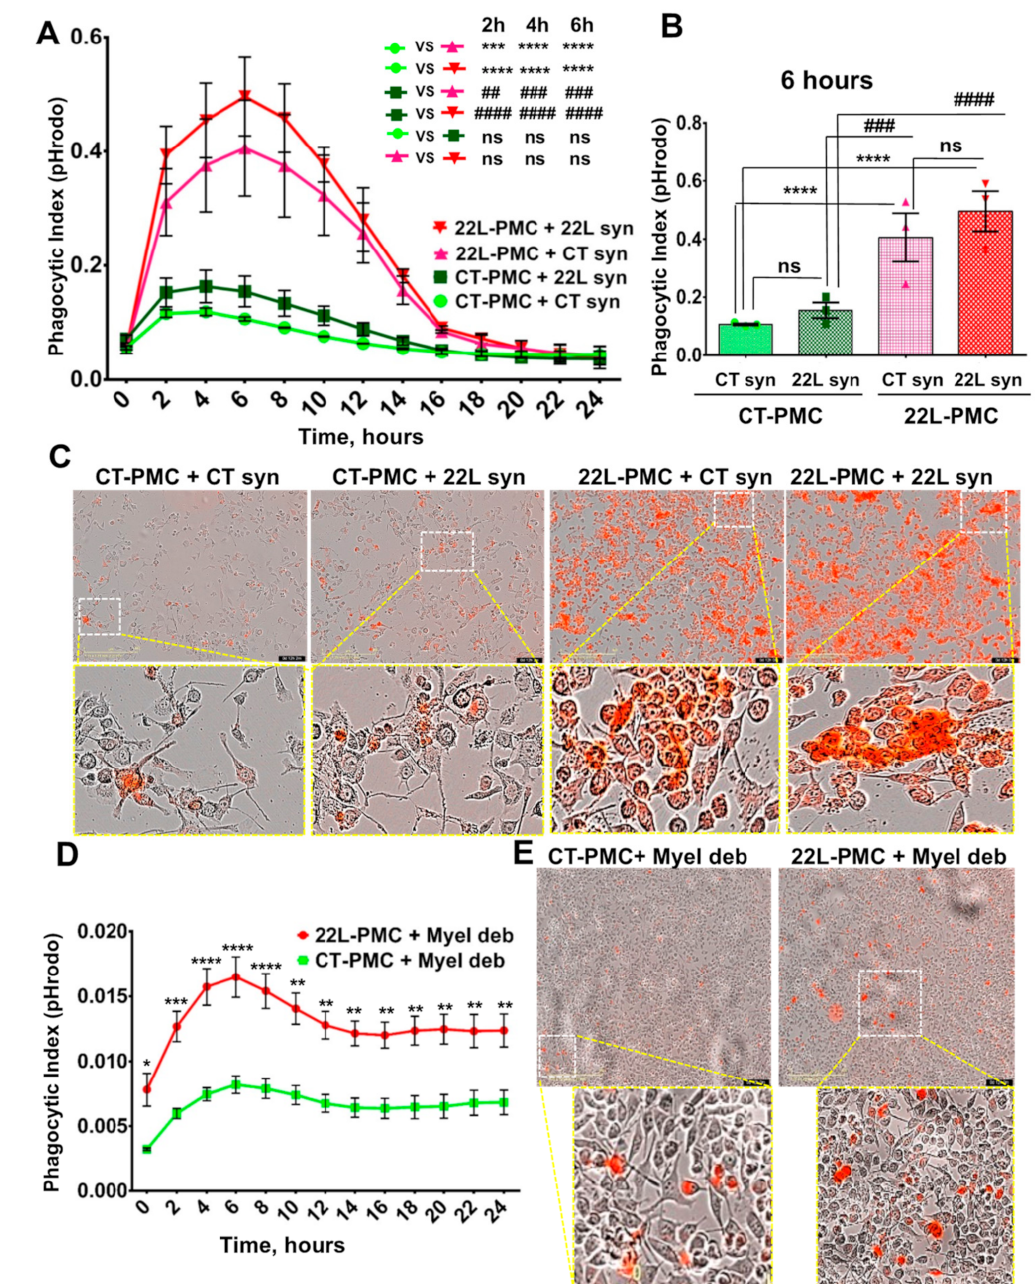
Figure 3. Live-cell imaging of phagocytic activity of PMCs. ( A ) Real-time, live-cell imaging of uptake of 22L-syn or CT-syn by 22L-PMCs or CT-PMCs monitored by pHrodo Red fluorescence assay over the time period of 24 h. ( B ) Analysis of phagocytic indexes measured by live-cell pHrodo Red fluorescence assay at the 6-h time point. ( C ) Representative overlaps of phase-contrast and fluorescence images of 22L-PMCs and CT-PMCs exposed to 22L-syn or CT-syn collected at the 12 h time point. ( D ) Real-time, live-cell imaging of uptake of myelin debris by 22L-PMCs and CT-PMCs over the time period of 24 h monitored by pHrodo Red fluorescence assay. ( E ) Representative overlaps of phase-contrast and fluorescence images of 22L-PMCs and CT-PMCs exposed to myelin debris. For all live-cell imaging assays, n = 3 22L-PMC or CT-PMC cultures, each isolated from an individual animal and cultured in three wells. For each well, four images were automatically acquired every 2 h. n = 3 independent isolations from individual animals for each 22L-syn, CT-syn, or myelin debris. Data presented as mean ± SEM. * p ≤ 0.05, ** or ## p ≤ 0.01, *** or ### p ≤ 0.001 and **** or #### p ≤ 0.0001, and ‘ns’ non-significant by a two-way ANOVA followed by Tukey’s